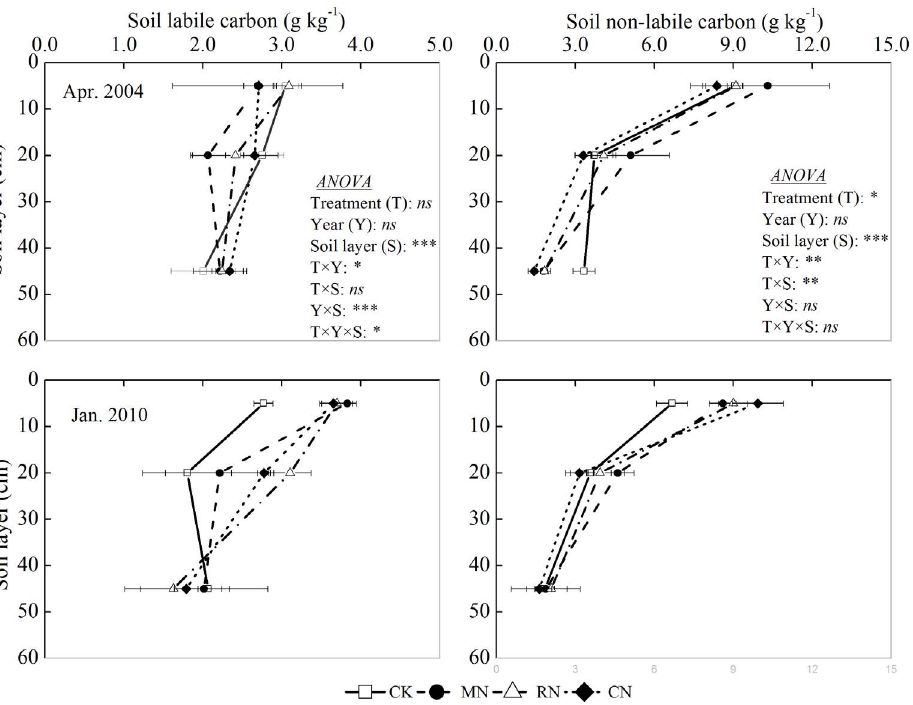
Figure 3. The distribution of the soil labile and non-labile carbon concentrations in the soil profile with different N treatments in the year-round greenhouse tomato planting system in Shouguang, northern China. Note: Note: *, ** and *** indicate significant differences at P , 0.05, P , 0.01 and P , 0.001, ns denotes no significant difference.